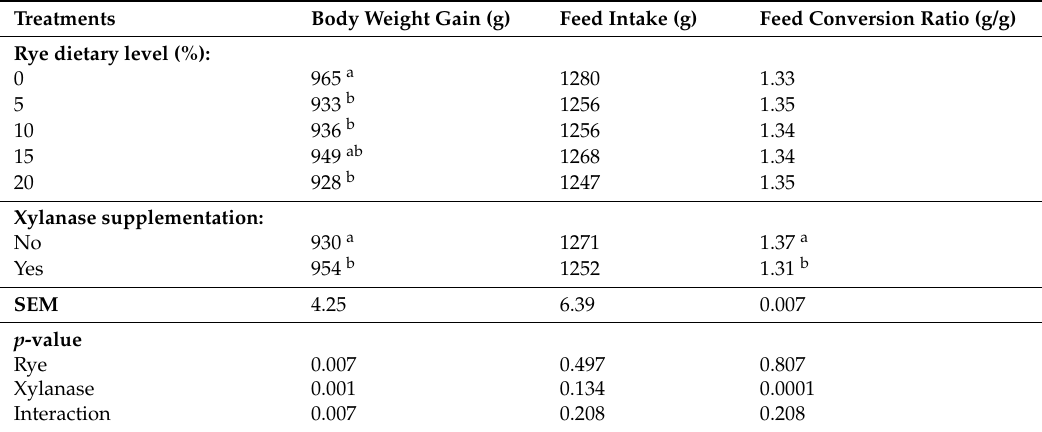
Table 3. Effects of dietary treatments on broiler performance in starter period of feeding 1 , 1–21 d of age. Treatments